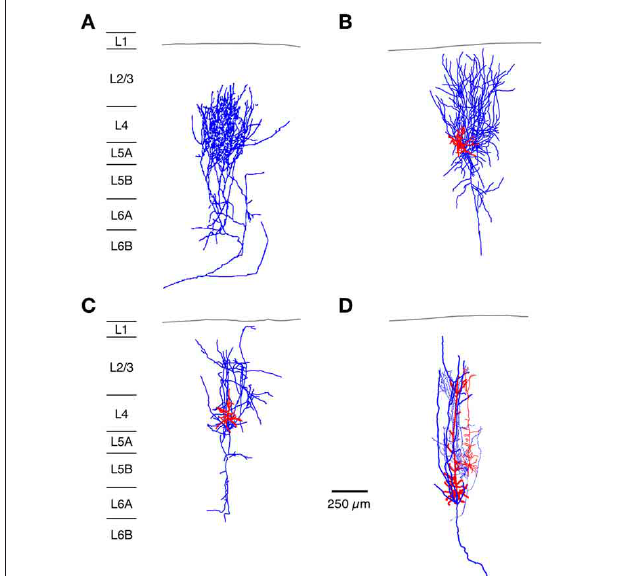
FIGURE 3 | Neuronal elements in the S1 barrel cortex with a predominantly vertical axonal organization. The figure shows four types of axonal projections (blue) with a predominantly vertical axonal projection that is largely confined to a barrel column in the whisker-related S1 cortex. (A) Most thalamic afferents from VPM nucleus of the thalamus arborize extensively in layer 4 in a barrel-restricted fashion, (B) L4 spiny stellate cell, (C) L4 star pyramidal cell, (D) corticothalamically projecting L6A pyramidal cell. The dendritic domain of intracortical neurons is given in red.